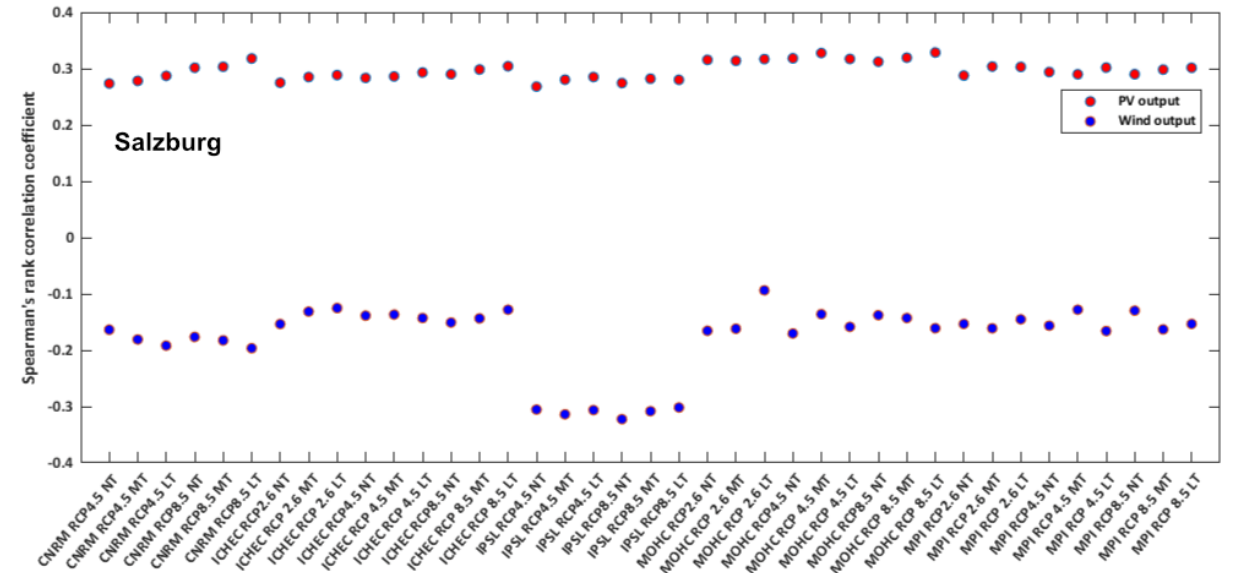
Figure 9. Spearman’s correlation between temperature and solar or wind output (Salzburg).